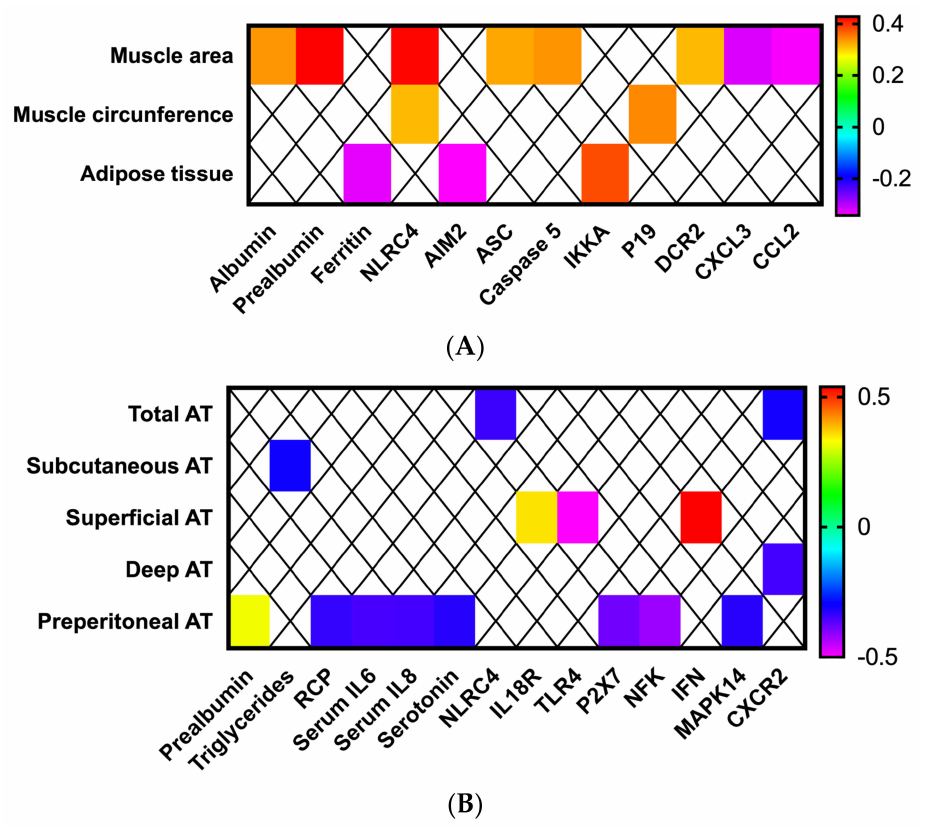
Figure 3. Morphofunctional nutritional assessment in patients with head and neck cancers. Corre- lations between ( A ) muscle echography, biochemical and molecular parameters, ( B ) adipose tissue echography, biochemical and molecular